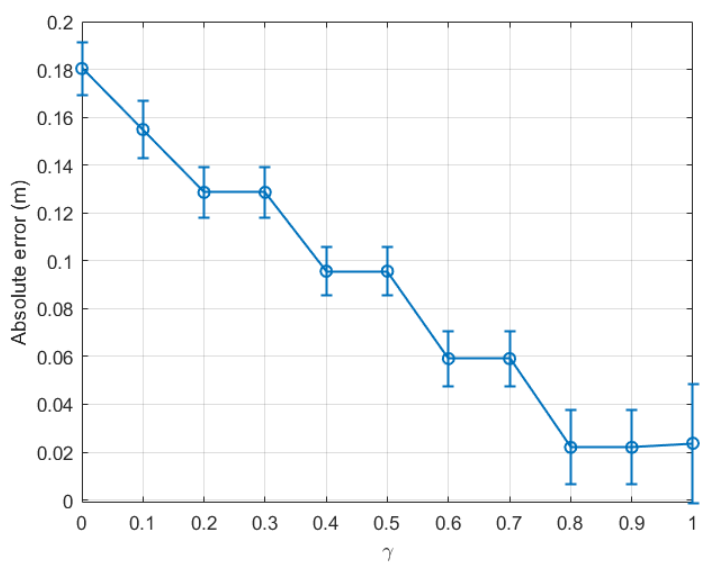
Figure 5. Indoor walking (dataset 1): absolute error of the last time window ( tw 12 ) with respect to γ ∈ [ 0,1 ] .